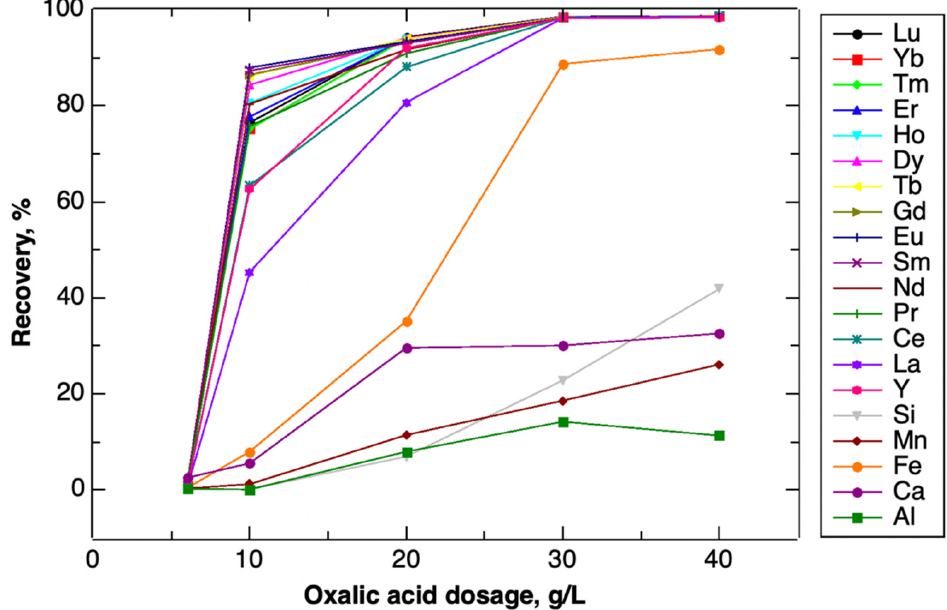
Figure 8. Effect of oxalic acid dosage on elemental recovery of rare earth elements and contaminants (Al, Ca, Fe, Mn, Si) at a fixed pH of 1.5 and reaction time of 2 h.